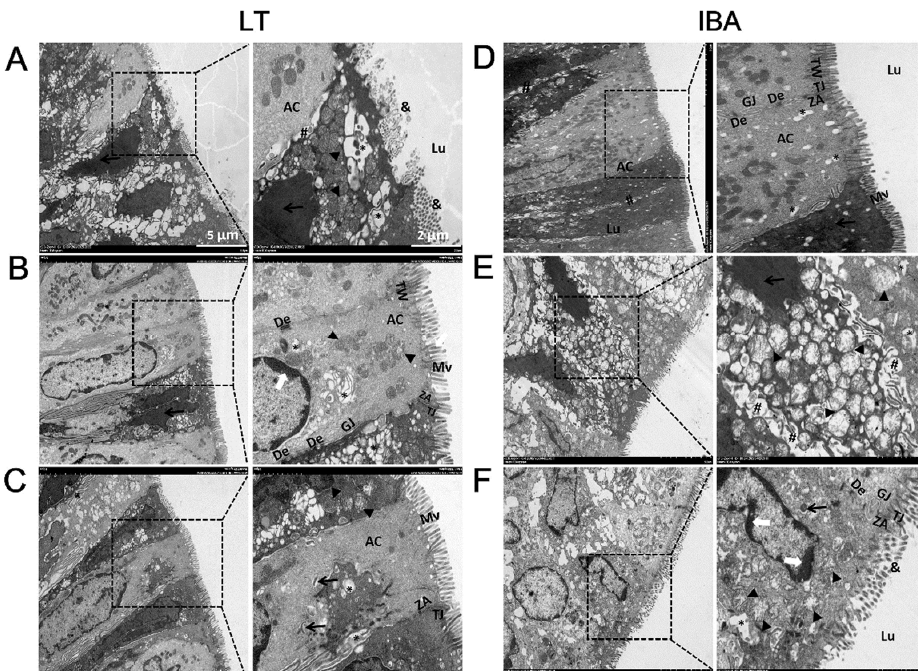
Figure 5. Transmission electron microscopy imaging of apoptotic cells in the colonic mucosa of the LT group ( A – C ) and IBA group ( D – F ) of Daurian ground squirrels. Colonic lumen (Lu), microvilli (Mv), microsomes (&), terminal network (TW), tight junctions (TJ), zonula adherens (ZA), desmosomes (De), gap junctions (GJ), enlarged cell–matrix gap (#), intranuclear chromatin agglutination, marginalization (white thick arrow), mitochondrial swelling, aggregation, or disruption of cristae structure (black triangle), vacuolated cellular debris in the nuclear periphery and cytoplasm (*), apoptotic bodies (black arrows). LT, late torpor; IBA, interbout arousal.